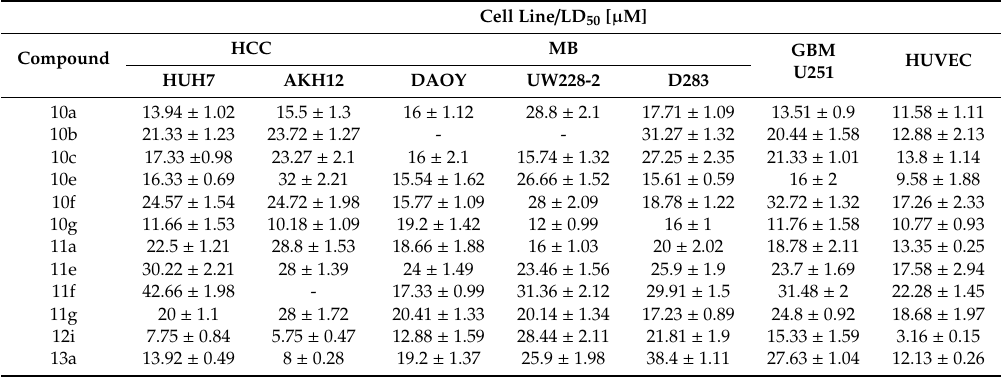
Table 1. LD 50 values for specified sulfonamides tested in Huh7, AKH12, DAOY, UW228-2, D283